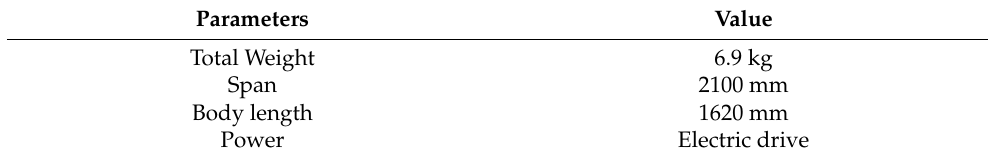
Figure 4. The experimental platform of the small fixed-wing UAV. Table 2. Parameters of fixed-wing UAV.